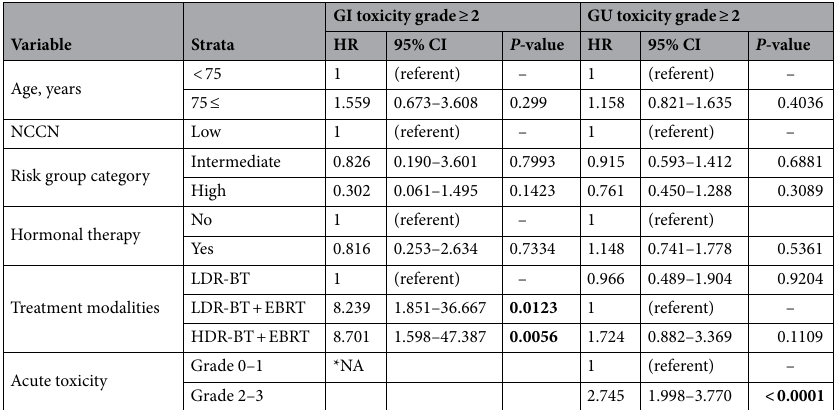
Table 6. Multi-variate analysis of late grade ≥ 2 GI/ GU toxicity. Bold values indicate statistically significance. CI confidence interval, HR hazard ratio, NA not available. *Incidence of GI acute toxicity was too low to